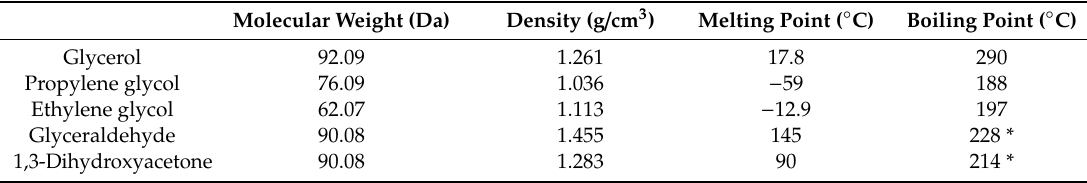
Table 1. Physicochemical data of polyalcohols.